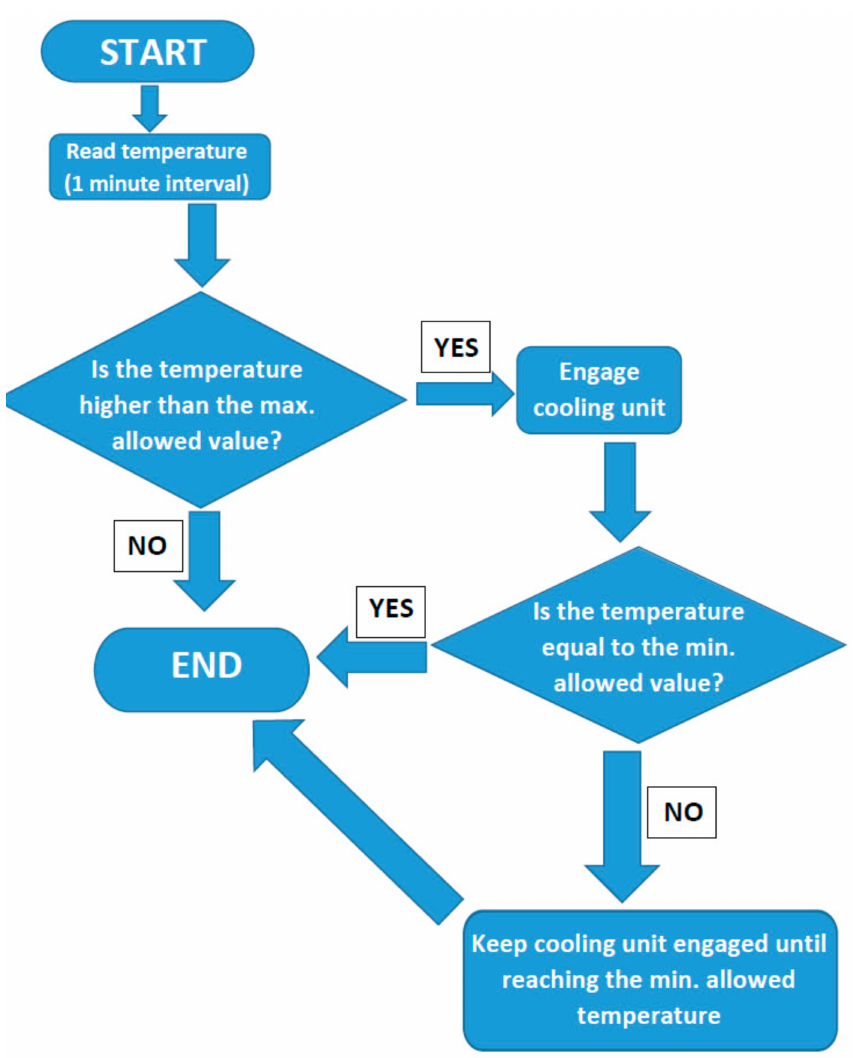
Figure 11. Structure of the temperature control algorithm.